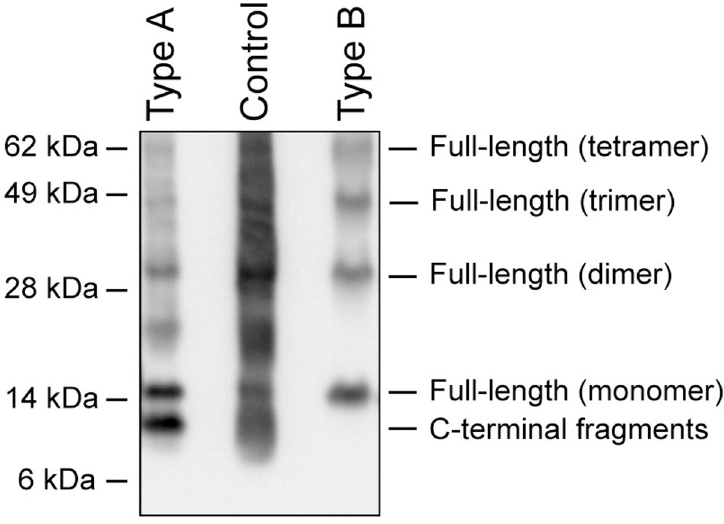
Fig 1. Typical examples of fibril composition type A and type B, visualized by western blot. A monoclonal antibody directed against TTR50-127 was used, which detects full-length TTR as well as the C-terminal fragments found in type A fibrils. Control = Cardiac tissue containing ATTR amyloid fibrils of type A.